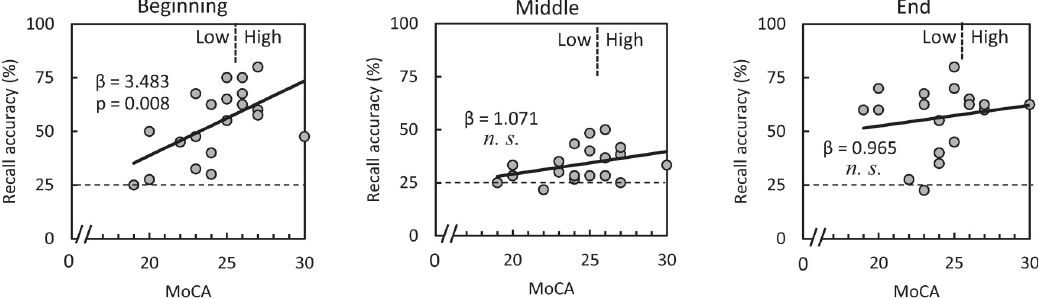
Fig 3. Relationships between MoCA score and recall accuracy. Repeated measures linear regression analysis demonstrated that MoCA score correlated only with the recall accuracy for numerals corresponding to arrows in the beginning sub-period. (n = 20; some data are overlapped each